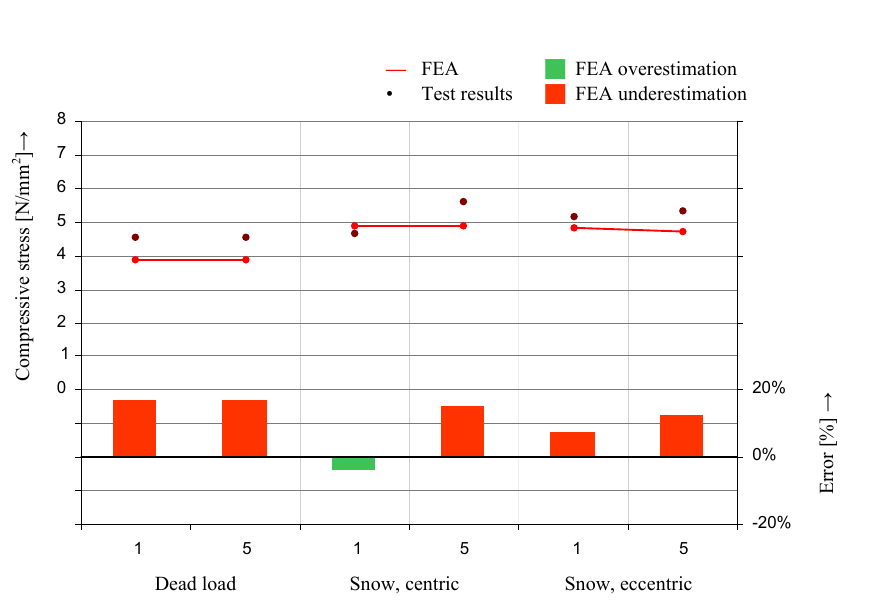
Figure 16: Measurement locations